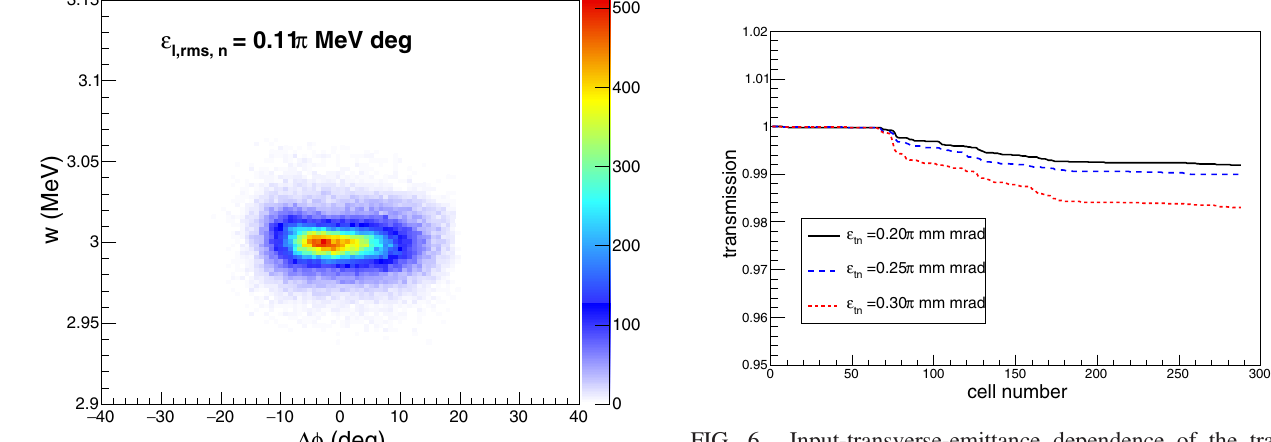
FIG. 6. Input-transverse-emittance dependence of the trans- mission. The solid, dashed, and dotted lines are transmis- sions for the input transverse emittances of 0.20, 0.25, and 0 . 30 π mm mrad,